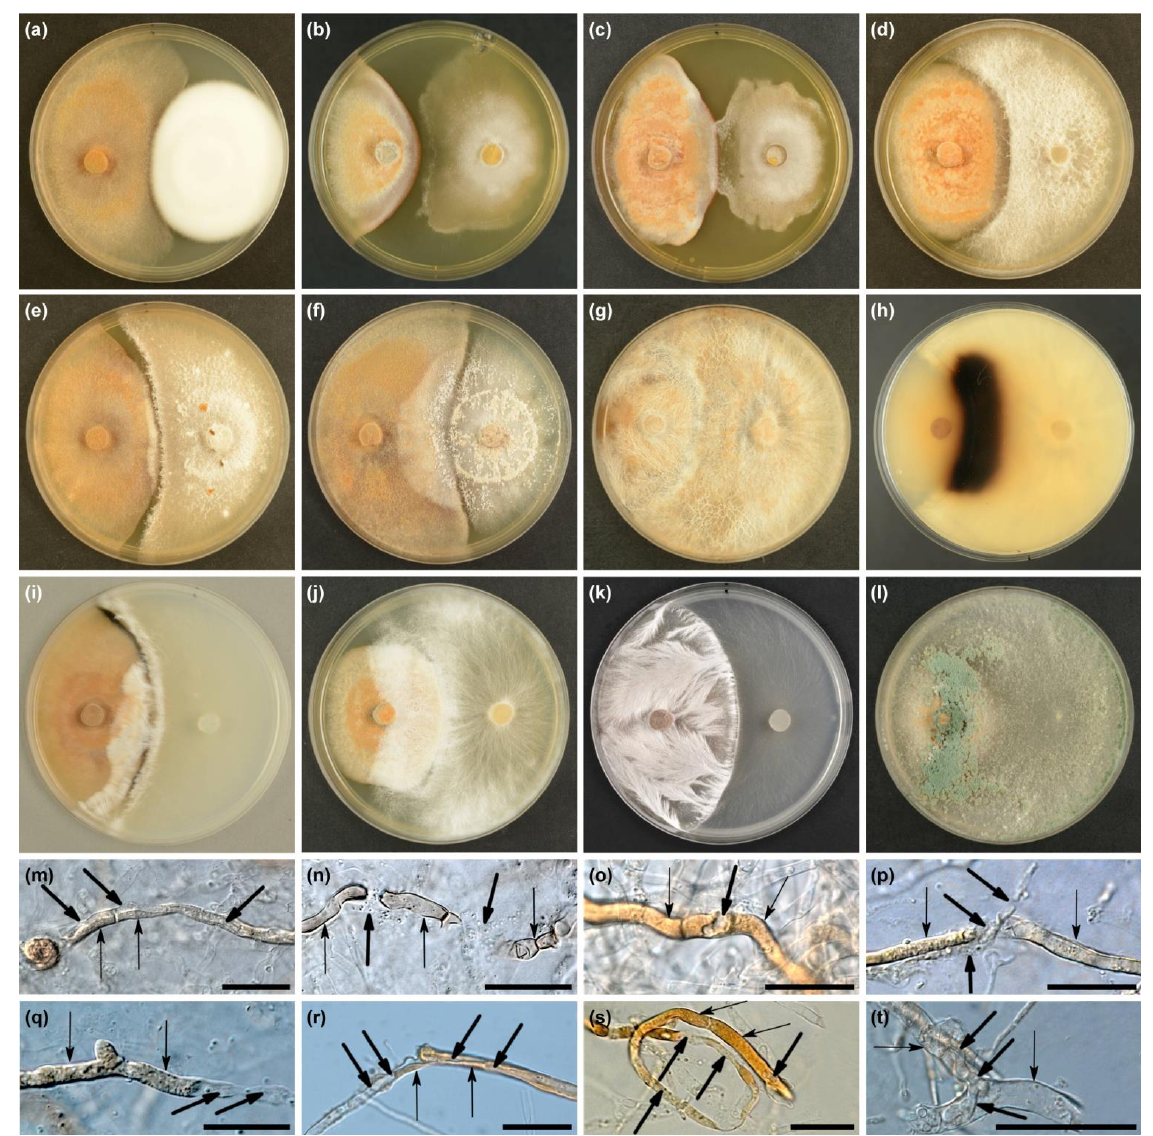
Figure 4. Various types of interactions observed in dual cultures ( a – l ) and morphological deformations ( m – t ) (MEA, 3 weeks, 20 °C), Hymenoscyphus fraxineus (either Hf1, Hf2 or Hf3) from the left, test fungus from the right: ( a ) type A interaction, Cordyceps sp. 1 Fe842F, ( b ) type B